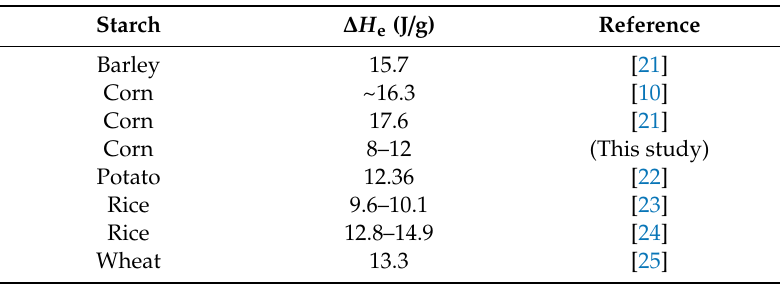
Table 2. Enthalpy of the gelatinization ( ∆ H e ) of waxy starches.